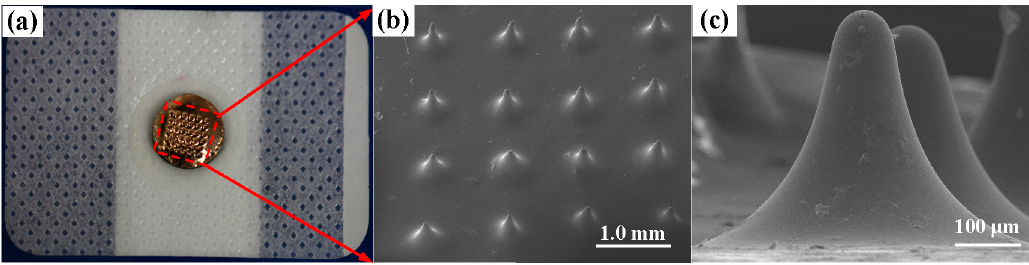
Figure 6. ( a ) Photo of the MAE; ( b ) SEM image of MA; and ( c ) SEM image of the micro-needles.